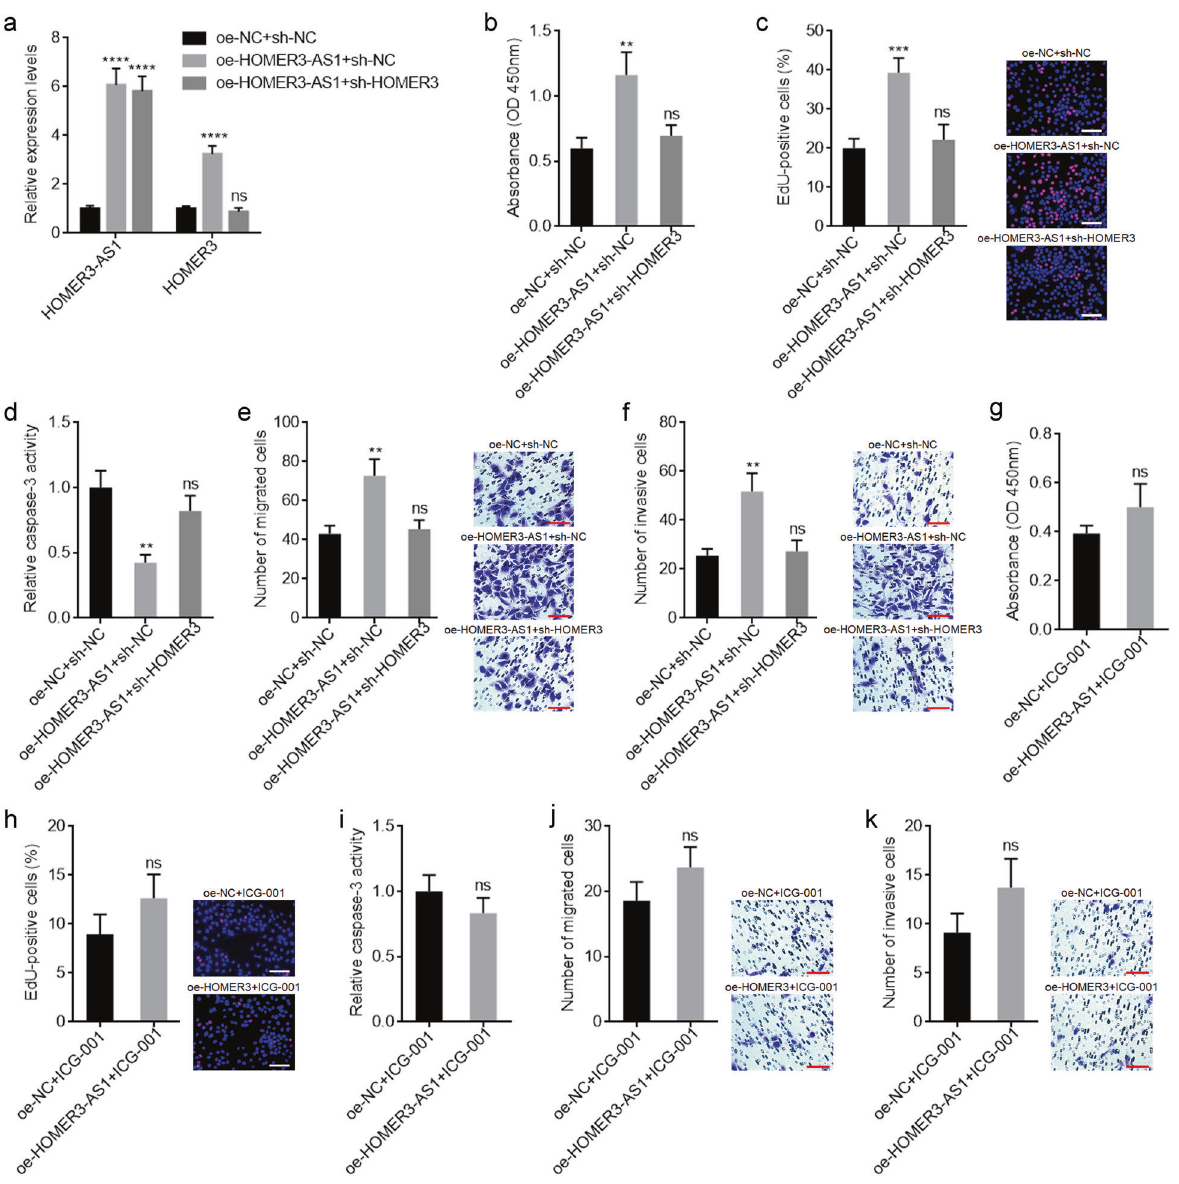
Fig. 5 Inhibition of HOMER3/Wnt/ β -catenin signaling abolished the oncogenic roles of HOMER3-AS1 in HCC. a HOMER3-AS1 and HOMER3 expression in SK-HEP-1 cells with HOMER3-AS1 overexpression and concurrent HOMER3 depletion. b Cell proliferation of SK-HEP-1 cells with HOMER3-AS1 overexpression and HOMER3 depletion was determined by CCK-8 experiments. c Cell proliferation of SK-HEP-1 cells with HOMER3-AS1 overexpression and HOMER3 depletion was determined by EdU incorporation experiments. Scale bars, 100 µm. d Cell apoptosis of SK-HEP-1 cells with HOMER3-AS1 overexpression and HOMER3 depletion was determined by caspase-3 activity assays. e Cell migration of SK-HEP-1 cells with HOMER3-AS1 overexpression and HOMER3 depletion was determined by transwell migration assays. Scale bars, 100 µm. f Cell invasion of SK-HEP-1 cells with HOMER3-AS1 overexpression and HOMER3 depletion was determined by transwell invasion assays. Scale bars, 100 µm. g Cell proliferation of HOMER3-AS1 overexpressed and control SK-HEP-1 cells treated with 10 μ M ICG-001 was determined by CCK-8 experiments. h Cell proliferation of HOMER3-AS1 overexpressed and control SK-HEP-1 cells treated with 10 μ M ICG-001 was determined by EdU incorporation experiments. Scale bars, 100 µm. i Cell apoptosis of HOMER3-AS1 overexpressed and control SK-HEP-1 cells treated with 10 μ M ICG-001 was determined by caspase-3 activity assays. j Cell migration of HOMER3-AS1 overexpressed and control SK-HEP-1 cells treated with 10 μ M ICG-001 was determined by transwell migration assays. Scale bars, 100 µm. k Cell invasion of HOMER3-AS1 overexpressed and control SK-HEP-1 cells treated with 10 μ M ICG-001 was determined by transwell invasion assays. Scale bars, 100 µm. Results are presented as mean ± SD based on three independent experiments. ** p < 0.01, *** p < 0.001, **** p < 0.0001, ns, not signi fi cant, by one-way ANOVA followed by Dunnett ’ s multiple comparisons test ( a - f ) or Student ’ s t -test ( g - k CSF-1 was signi fi cantly upregulated in SK-HEP-1 and SNU-398 macrophages in fi ltration and polarization. The results revealed cells with HOMER3-AS1 overexpression compared with control SK- that the HCC tissues with high levels of CD163 + macrophages HEP-1 and SNU-398 cells (Fig. 7a). Conversely, the CSF-1 also had higher HOMER3-AS1 and CSF-1 expression levels than expression level was signi fi cantly reduced after HOMER3-AS1 those HCC tissues with low levels of CD163 + macrophages (Supplementary Fig. 5e).